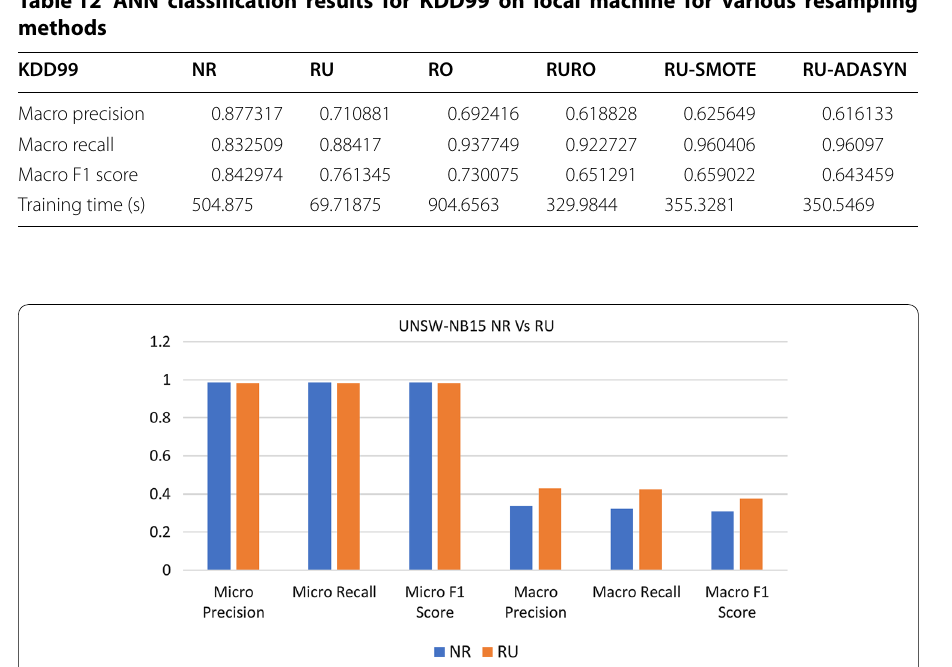
Fig. 5 Comparison for micro and macro metrics on